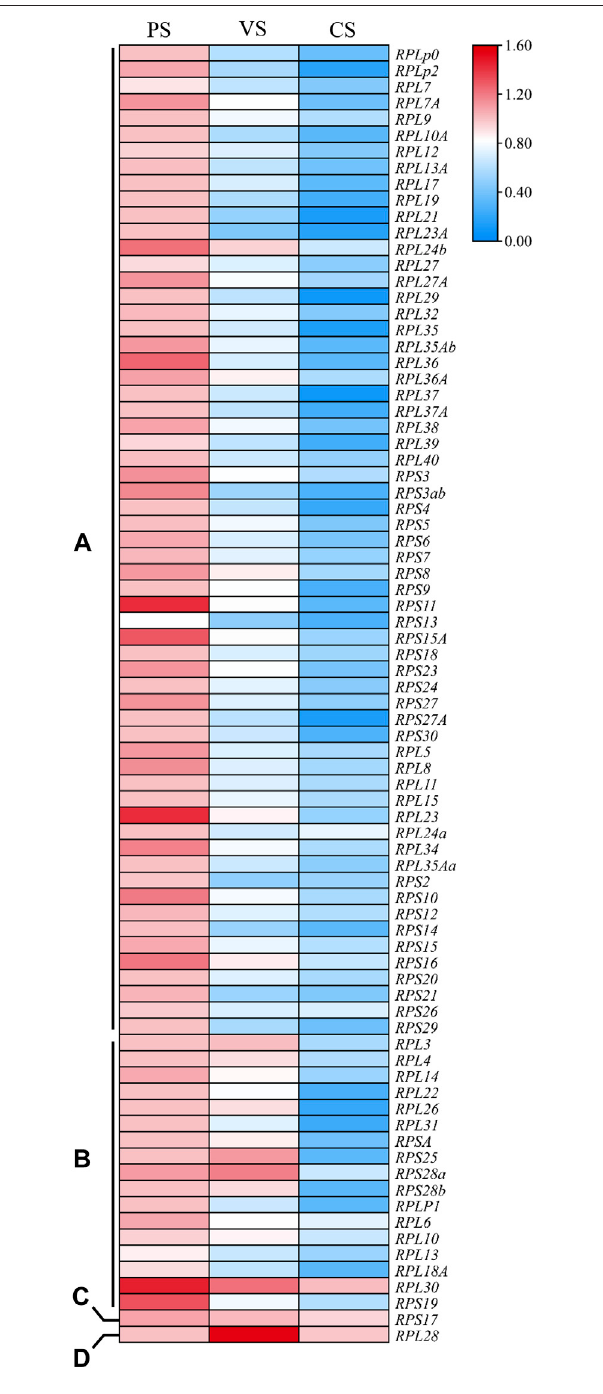
FIGURE 5 | The heatmap for the expression patterns of Rp genes in oogenesis of S. litura , including previtellogenesis stage (PS), vitellogenesis stage (VS.) and choriogenesis stage (CS). (A – D) represented four different expression types of Rp genes among these three stages. The mean expression values were calculated from three independent biological replicates,and signi fi cance wasdetermined usingone-wayANOVA. p value < 0.05 represents signi fi cant difference. The heatmap was performed using Tbtools(V1.098669)softwarebasedontherelativemRNAexpressionlevelof SlR p